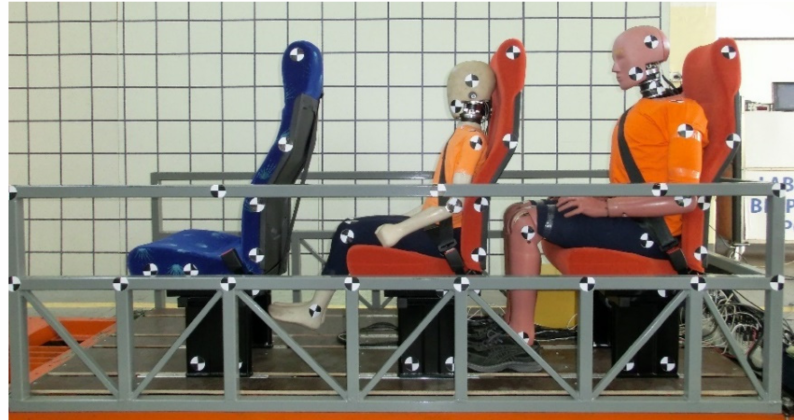
Figure 4. Test stand located at the Automotive Industry Institute in Warsaw.